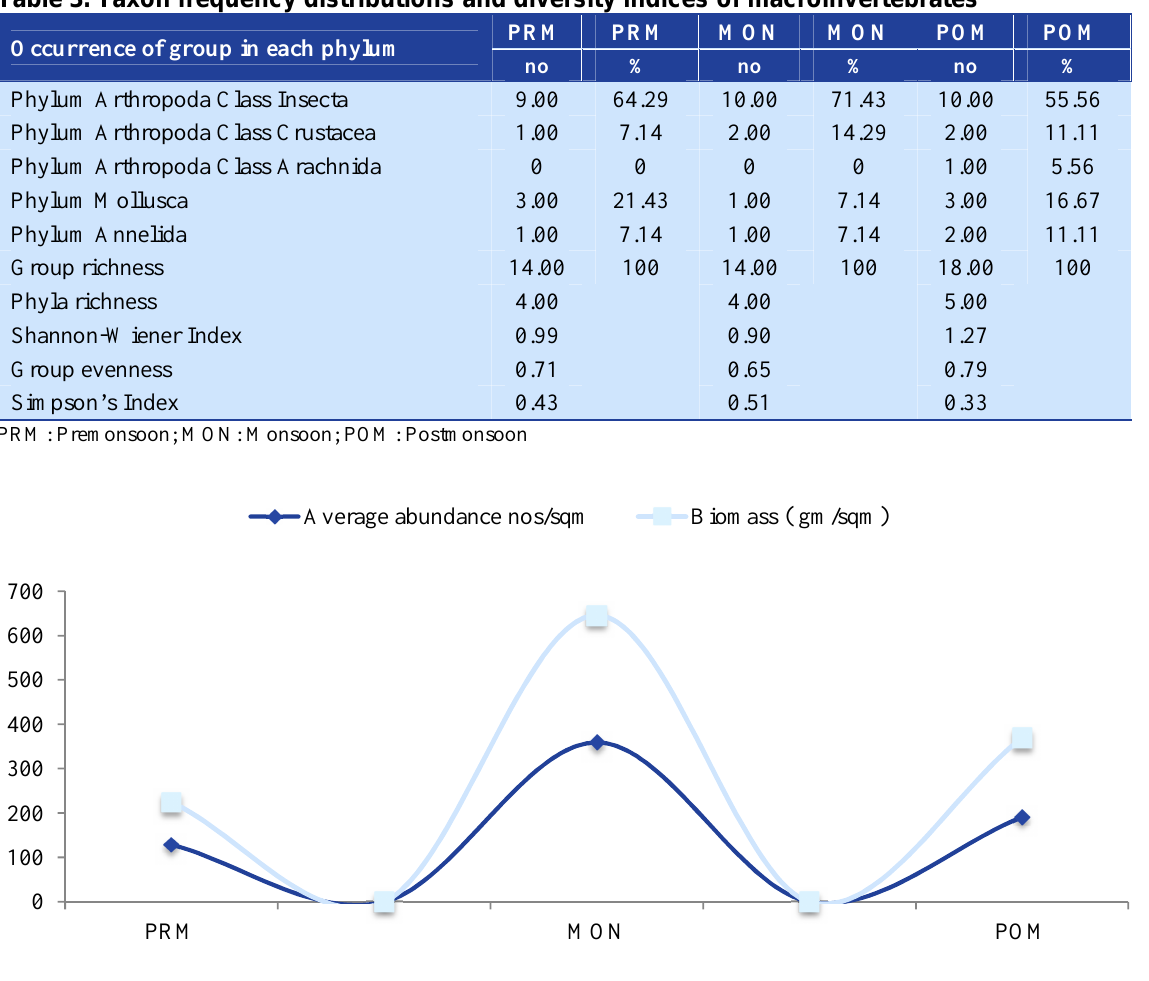
Figure 2. Seasonal variations in occurrence of macroinvertebrates PRM: Premonsoon; MON: Monsoon; POM: